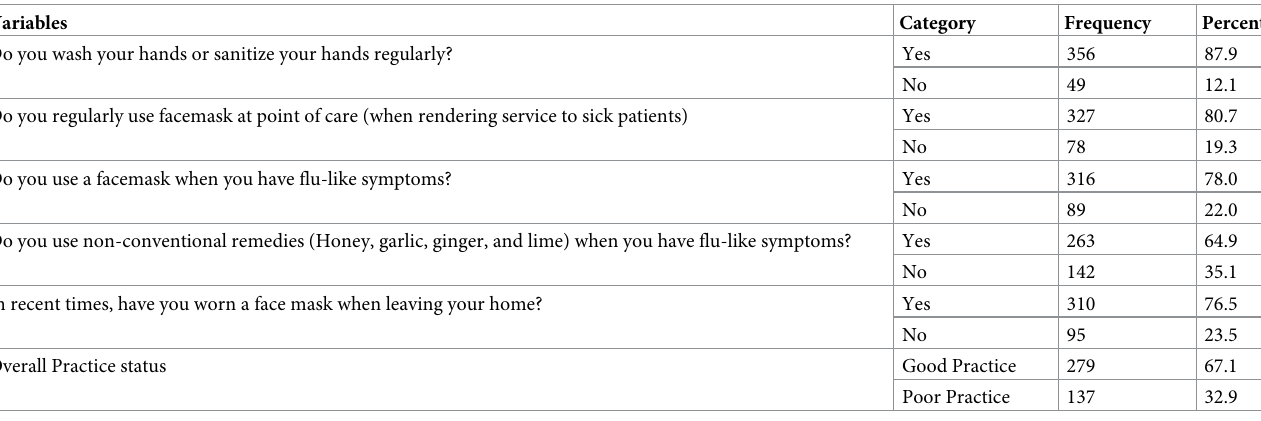
Table 5. COVID-19 prevention practices among HCWs working at hospitals of southwestern Ethiopia, 2021 (n = 405).